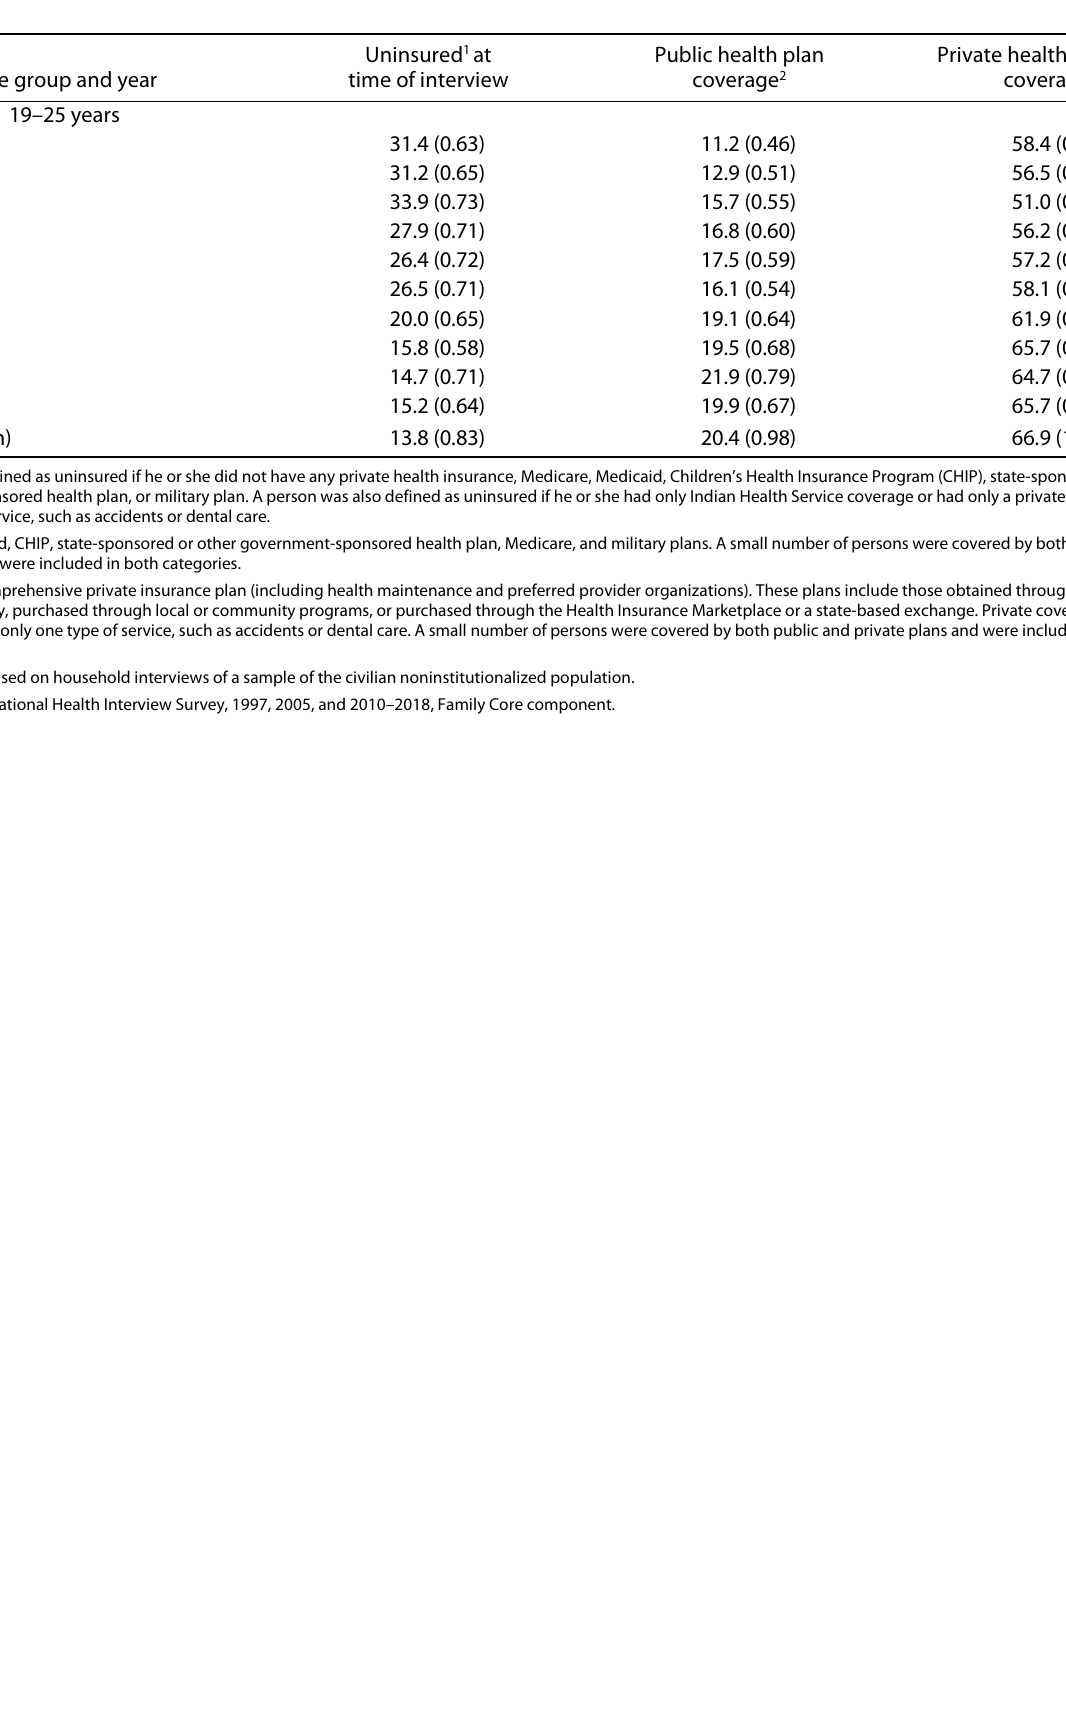
Table III. Percentages (and standard errors) of persons who lacked health insurance coverage, had public health plan coverage, and had private health insurance coverage at the time of interview, by age group and selected years: United States, 1997–June 2018—